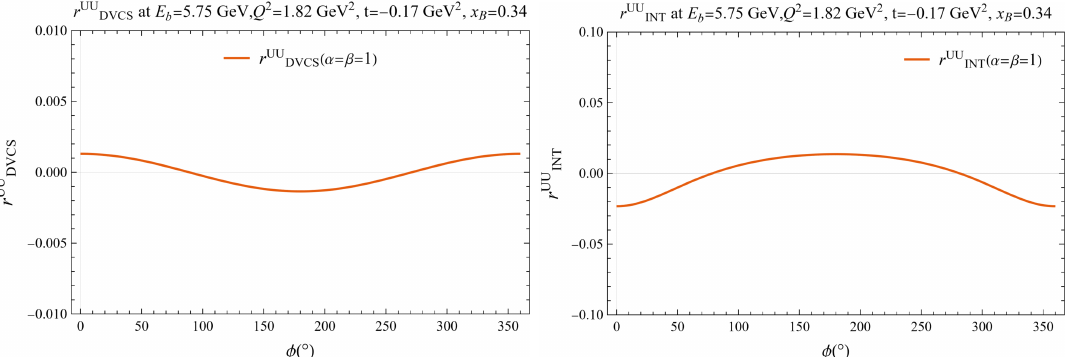
Figure 10 . The ratio r UU defined above in the unpolarized case, calculated at one given DVCS / INT kinematic point and radiation gauge in the lab frame with V = P . The gauge dependence is in general not significant, though it is more relevant in the case of interference